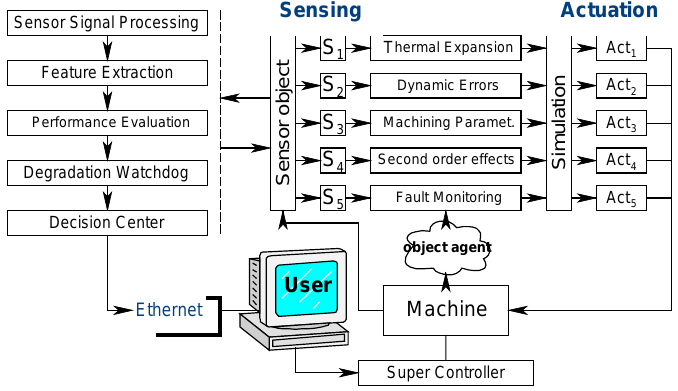
Figure 11. Intelligent sensor cluster activity for the next NC machines generation.